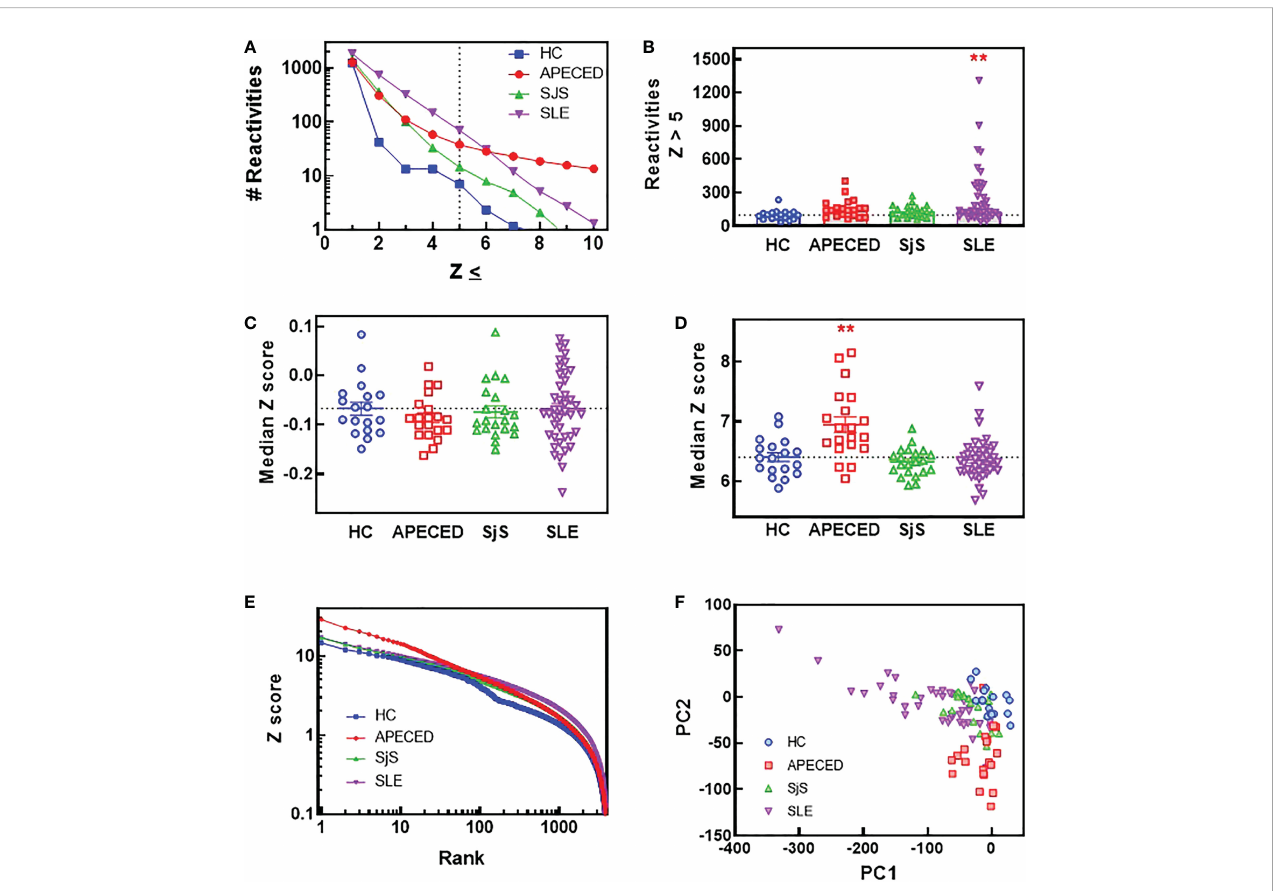
FIGURE 1 ProtoArray analysis of autoimmune patients reveals that autoantibody repertoires differ in the number of reactivities and their clonality between diseases. Plasma samples from patients and HCs were tested using the human ProtoArray covering 9483 proteins for IgG reactivity. Z scores were calculated to quantify reactivity for patients versus the HC group. (A) The median number of reactivities above a Z score threshold ranging from 1 to 10 were plotted for each group. (B) The number of reactivities with a median Z score >5 are plotted for each group. (C) The median Z score is plotted for each subject and also (D) for only reactivities with a Z score >5. (E) The top 4000 reactivities for each group are plotted ranked by highest Z score with the Z score for each reactivity on the Y axis. (F) A PCA plot was constructed of all subjects based on the ProtoArray data. (**signi fi cantly different from HC ANOVA p<0.01). HCs, healthy controls; IgG, immunoglobulin G; PCA, principal component